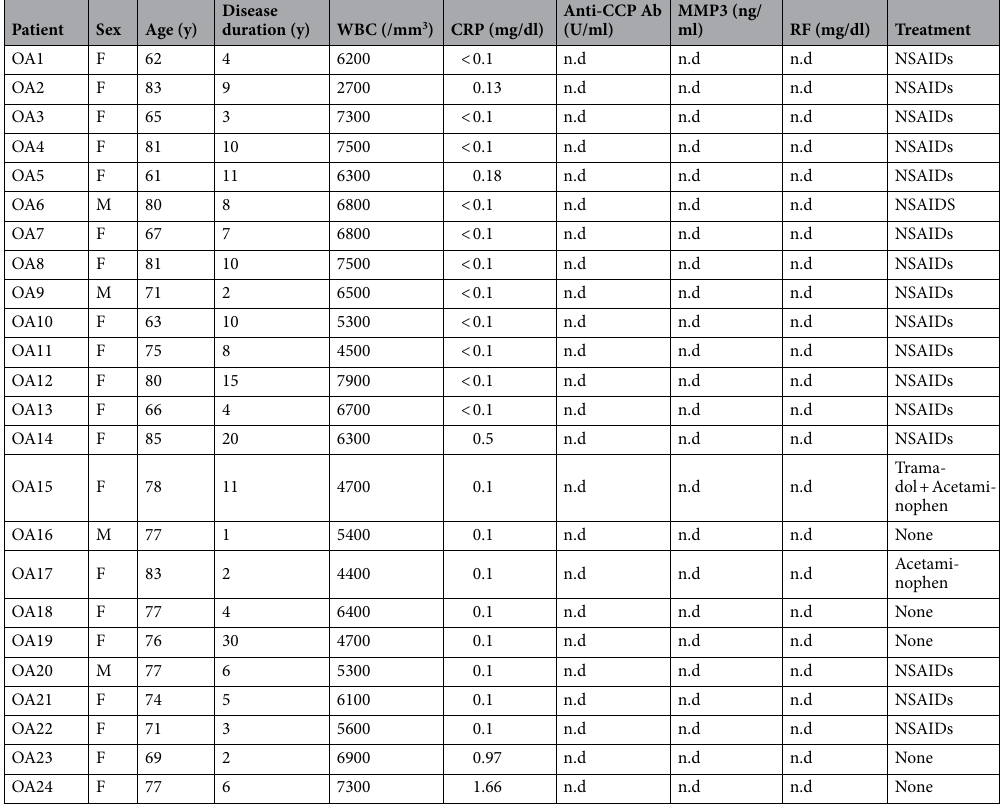
Table 2. Characteristics of patients with OA. anti-CCP Ab anti-cyclic citrullinated peptide antibody, CRP C-reactive protein, F female, M male, MMP3 matrix metalloproteinase 3, n.d not done, NSAIDs non-steroidal anti-inflammatory drugs, OA osteoarthritis, RF rheumatoid factor, WBCs white blood cells.